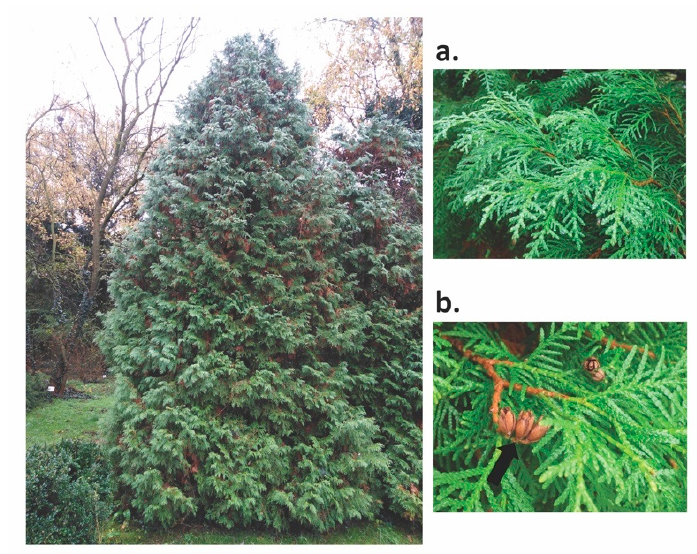
Figure 1. Specimen of T. occidentalis from the “Pavel Covaci” University Botanical Garden of Macea, Romania; detail: twig of leaves showing the flattened branches ( a ) and small pins containing the seeds ( b ).